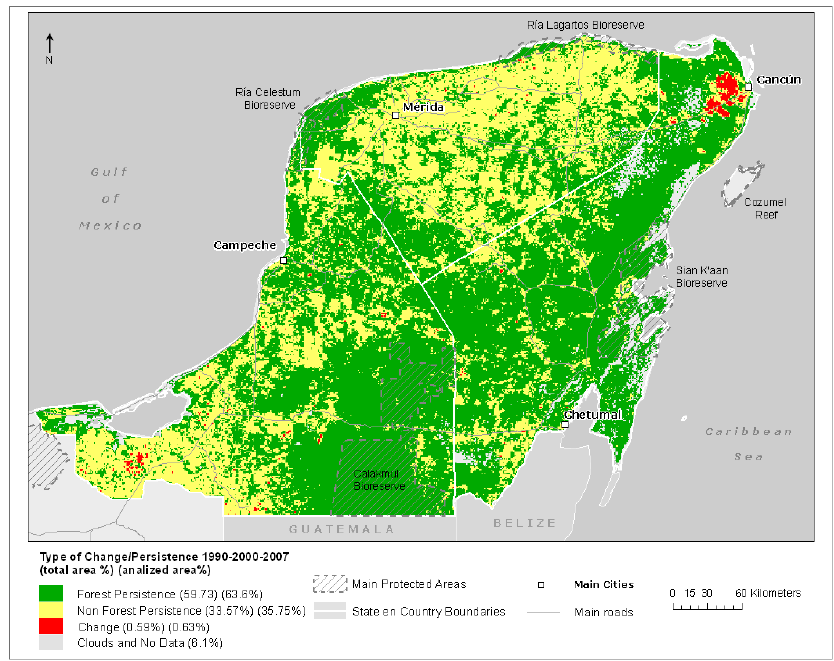
Figure 3. Land change/persistence classes based on the CABS (2009) land cover maps.